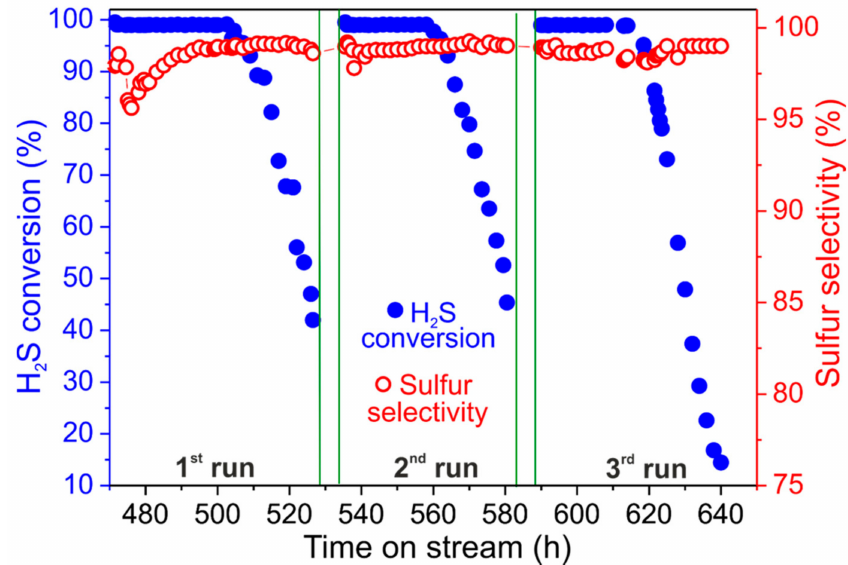
Figure 7. Desulfurization performance on NiS 2 /SiC foam catalyst as a function of successive catalyst/regeneration cycles; blue spheres refer to H 2 S conversion and empty red spheres refer to sulfur selectivity. Reaction conditions: [H 2 S] = 1 vol.%, [O 2 ] = 2.5 vol.%, O 2 -to-H 2 S ratio = 2.5, [H 2 O] = 30 vol.%, balance helium, reaction temperature = 60 ◦ C, GHSV (STP) = 1200 h − 1 . Green lines indicate the catalyst regeneration time (320 ◦ C in helium for 2